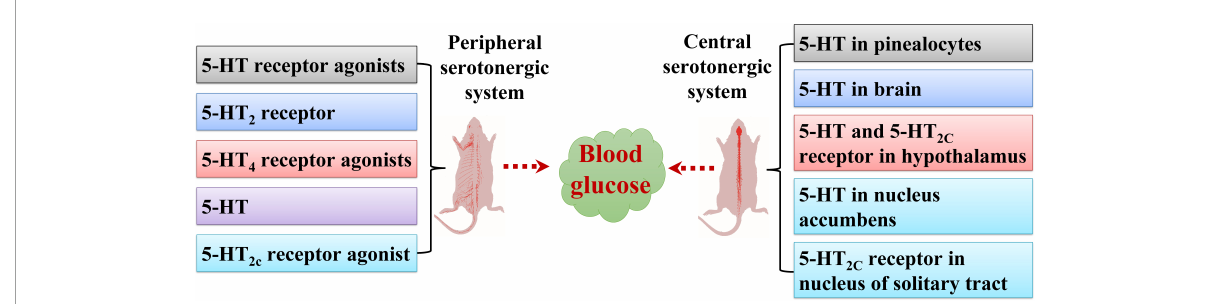
FIGURE1 Effects of peripheral and central serotonergic systems on blood glucose levels. 5-HT, 5-HT 2 receptor, 5-HT receptor agonists, 5-HT 4 receptor agonists, and 5-HT 2 c receptor agonists regulate blood glucose levels via the peripheral serotonergic system. 5-HT in the brain, pinealocytes, nucleus accumbens, and hypothalamus and 5-HT 2 C receptors in the hypothalamus and nucleus of the solitary tract are involved in modulating blood glucose levels via the central serotonergic